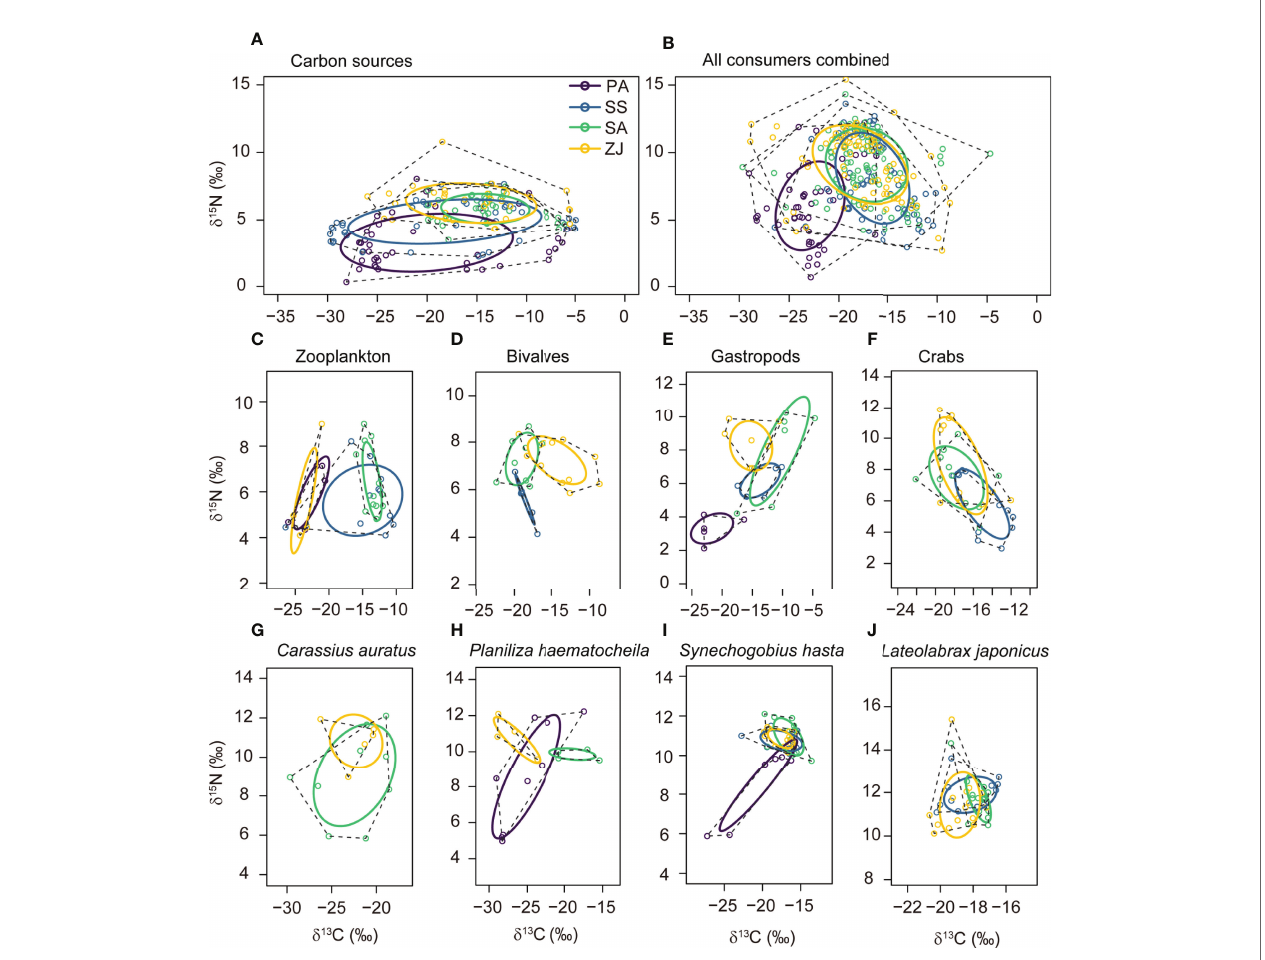
FIGURE 4 | Corrected standard niche ellipses (solid lines) and convex hulls (dashed lines) for the isotope-based niche areas of (A) the carbon sources, consisting of detritus and primary producers; (B) all consumers combined; and (C-J) individual consumer trophic groups for the Phragmites australis (PA), Suaeda salsa (SS), Spartina alterni fl ora (SA), and seagrass Zostera japonica seagrass (ZJ) habitats along the coastal topographic gradient in the Yellow River Delta wetland. Graphs were produced using the SIBER package implemented in the R software. Each point shows the d 13 C and d 15 N values for a sample, with colors based on the habitat where this data was collected. The ellipses, hulls, and data points for a given consumer trophic group collected in a given habitat in (C) to (J) are only provided when the sample size is ≥